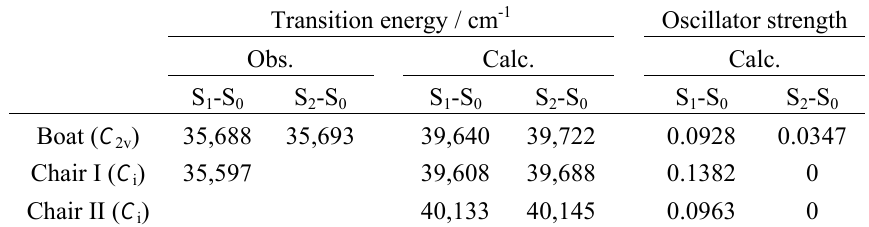
Table 2. S -S and S -S transition energies and oscillator strengths of DB18C6. The 1 0 2 0 calculated values are obtained at the TD-B3LYP/6-31+G* level without